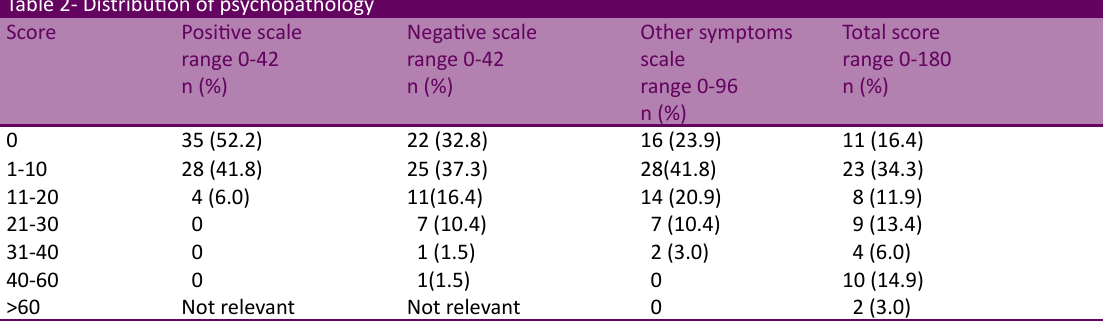
Table 2- Distribution of